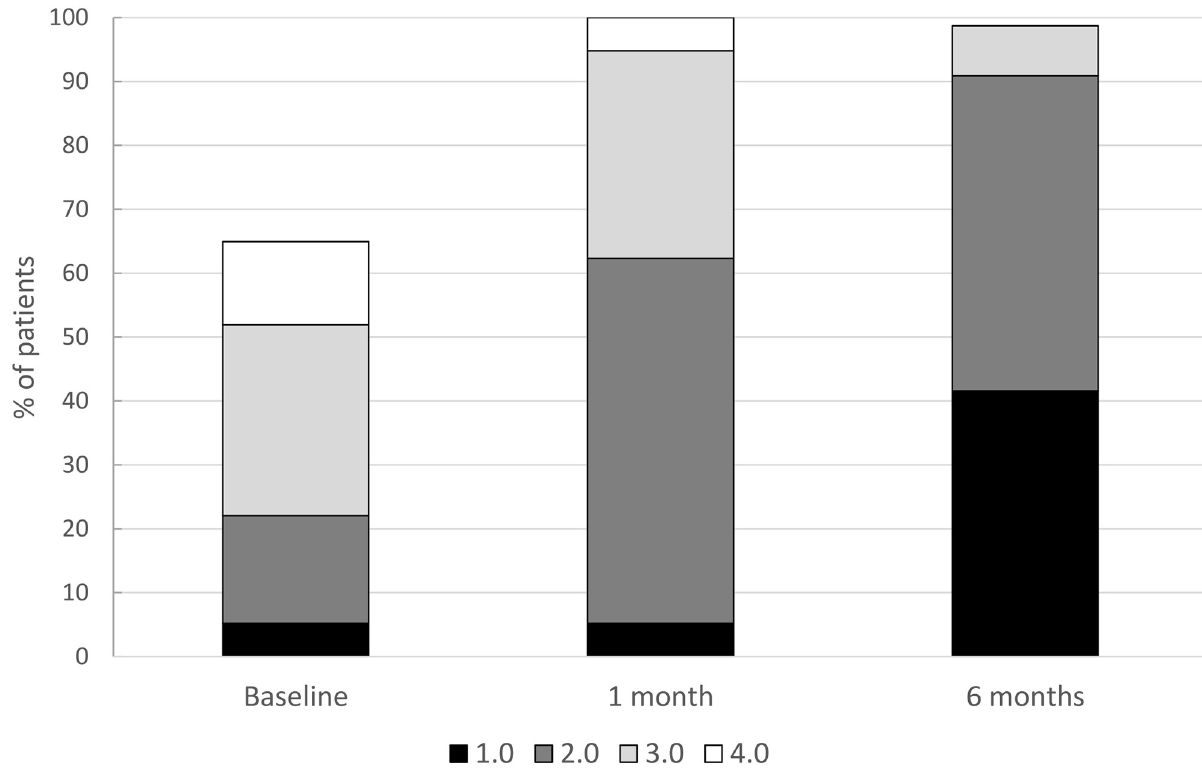
Fig 9. ELM grade change. Change in ELM severity grade after surgical repair for macula-involving rhegmatogenous retinal detachment (miRD). ELM was qualitatively graded in the subfoveal OCT into grade 1: normal and continuous; grade 2: altered but continuous; grade 3: interrupted but recognizable; and grade 4: not recognizable. The graph shows the qualitative recovery of the ELM in OCT imaging after vitrectomy for miRD.